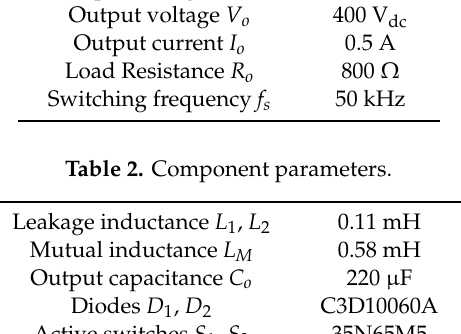
Table 2. Component parameters.